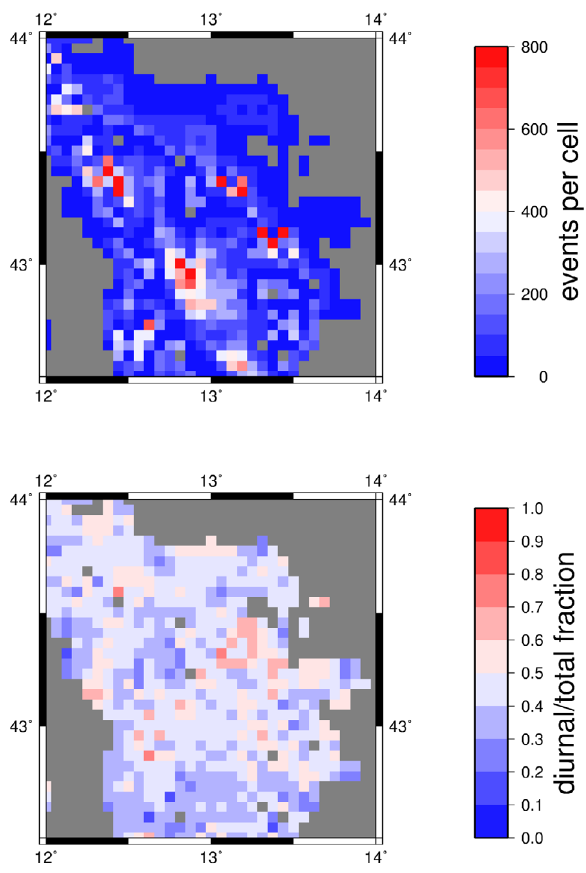
Figure 12. Day/night distribution of events in the catalogue with non- tectonic events removed. Top panel: number of events for each cell. Bottom panel: ratio of daytime to total events for each 5 km square cell. Dark blue and dark red colors depict the most anomalous areas. The residual anomalous areas are now linked to low-sampled